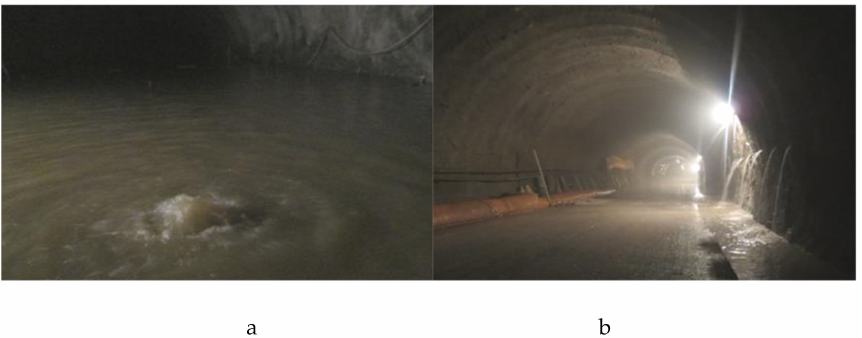
Photographs of water gushing from the tunnel scene: ( a ) normal bottom flush; ( b ) fracture-type normal water.